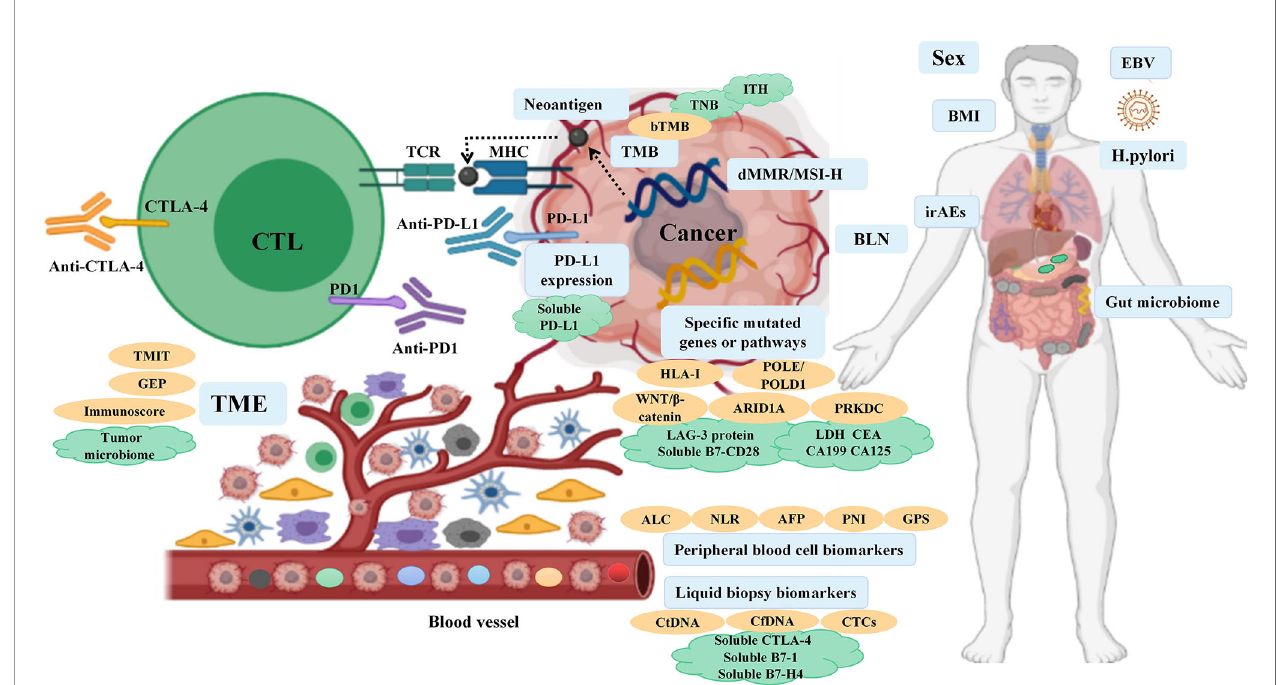
FIGURE 1 | Overview of the biomarkers for predicting the response to ICI therapy in digestive system